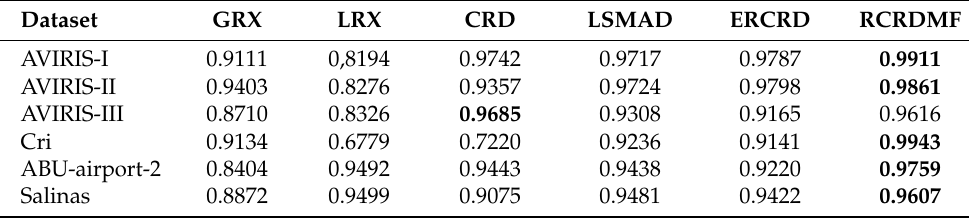
Table 1. The area under the receiver operating characteristic (ROC) curve (AUC). Values by different methods on the six datasets.